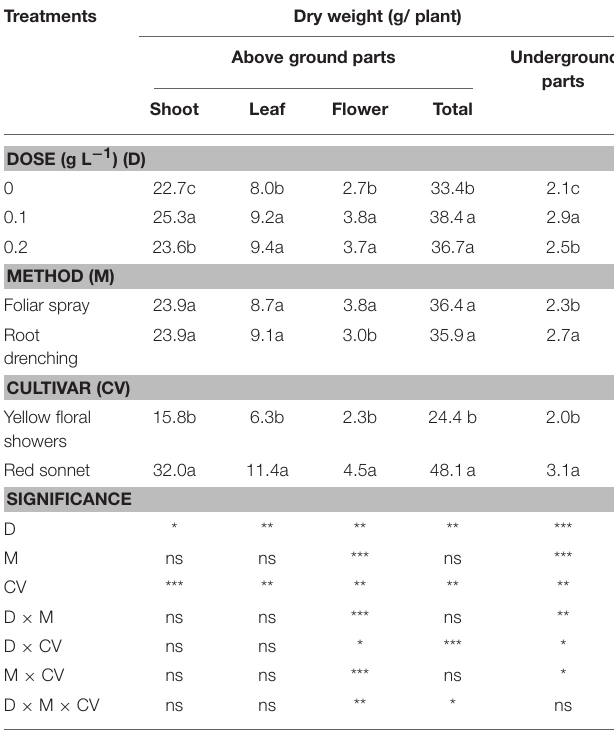
TABLE 3 | Main effects of biostimulant dose, application method and cultivar on dry weights in various parts of snapdragon